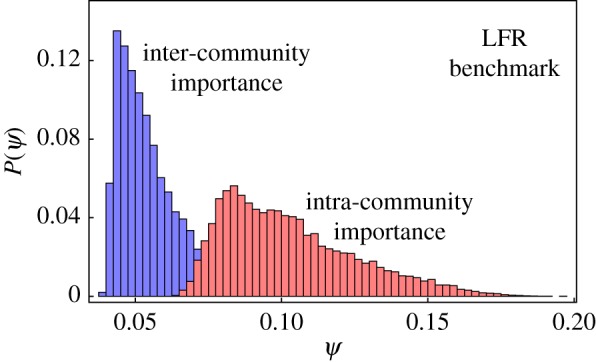
The GENs applied to the Liancichinetti, Fortunato and Radicchi benchmark [10]. The red shows the distribution of importance for nodes i and j that are in the same community but do not share a direct connection. The blue shows the distribution for those in different communities (and still sharing no direct connection). Owing to the high density of links inside of the communities, the GENs accurately indicate that ψij is likely to be larger if i and j are in the same community.